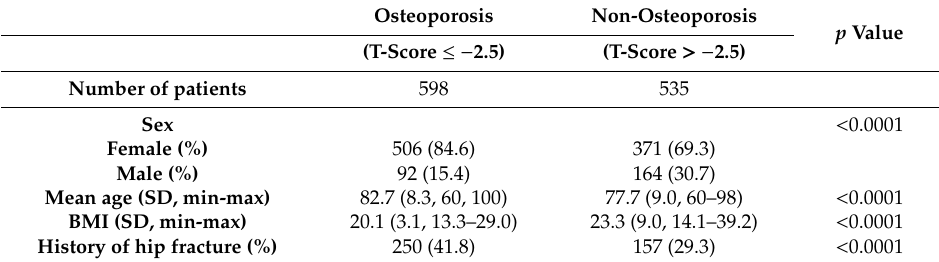
Table 1. Clinical and demographic characteristics of the hip radiographic dataset in this